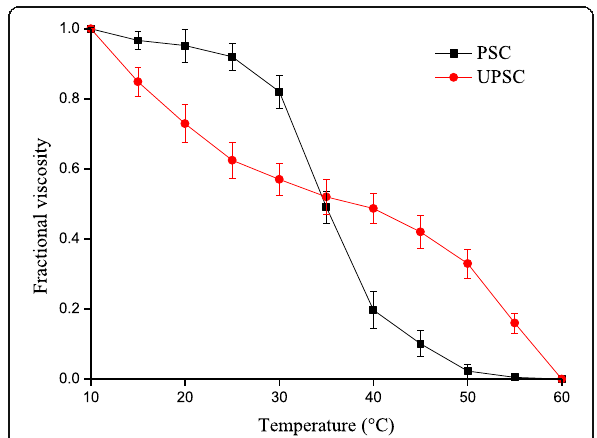
Fig. 4 Thermal denaturation curves of PSC and UPSC from chicken lung